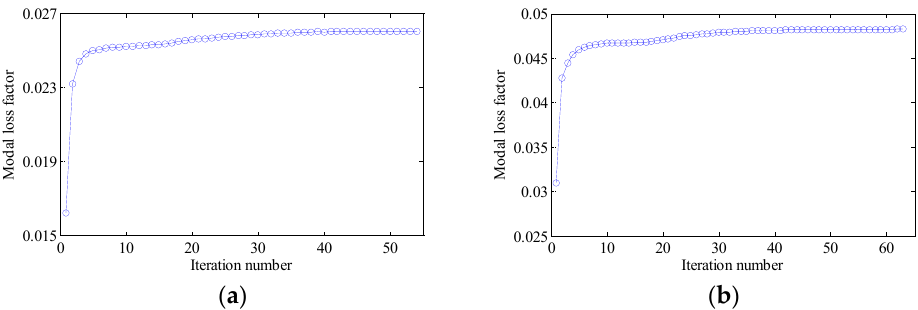
Figure 13. Iteration histories for different optimization objectives: ( a ) Objective 2: maximizing the second modal loss factor; ( b ) Objective 3: Maximizing the sum of the first two modal loss factors.